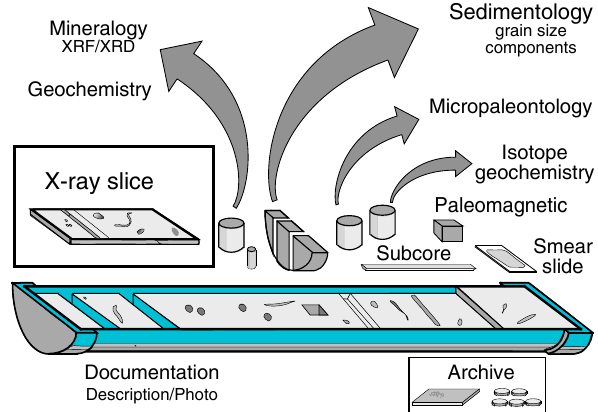
Figure 1. Standard sampling workflow for the investigation of sed- iment cores as developed at GIK. The first step during the sampling sequence was the preparation of sediment slabs for X-ray imaging along the core